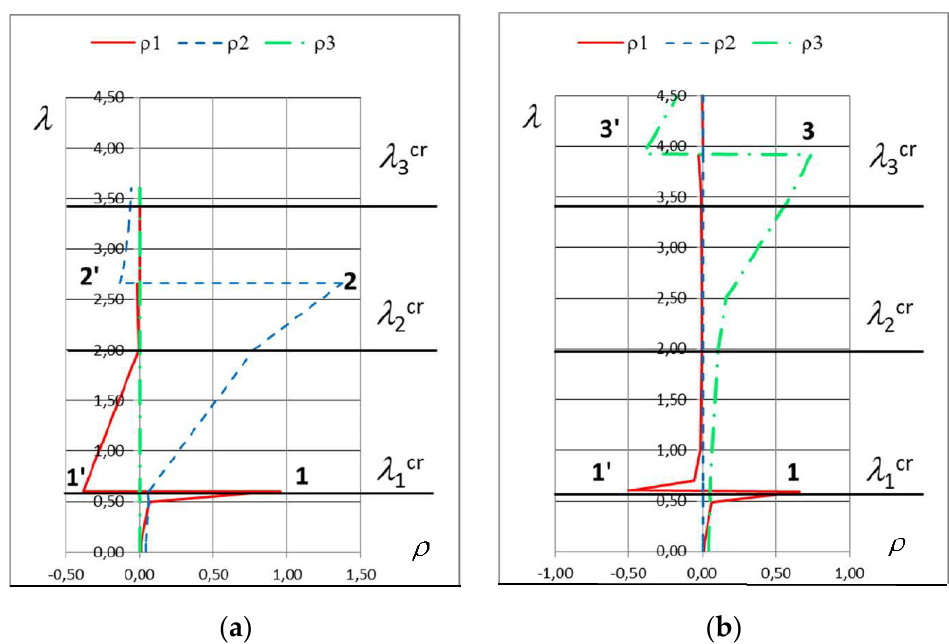
Figure 19. Coefficient ρ for geometrical imperfections: ( a ) m 1s 2 , ( b ) m 1 s 3.